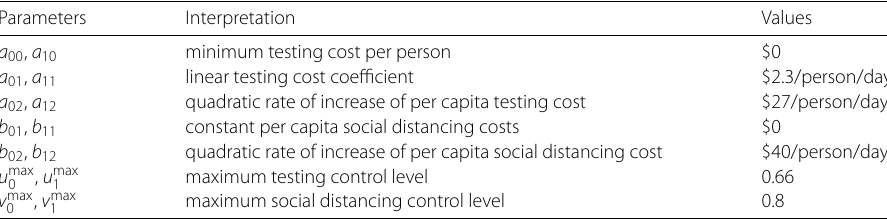
Table 2 Testing and social distancing control cost and level parameters